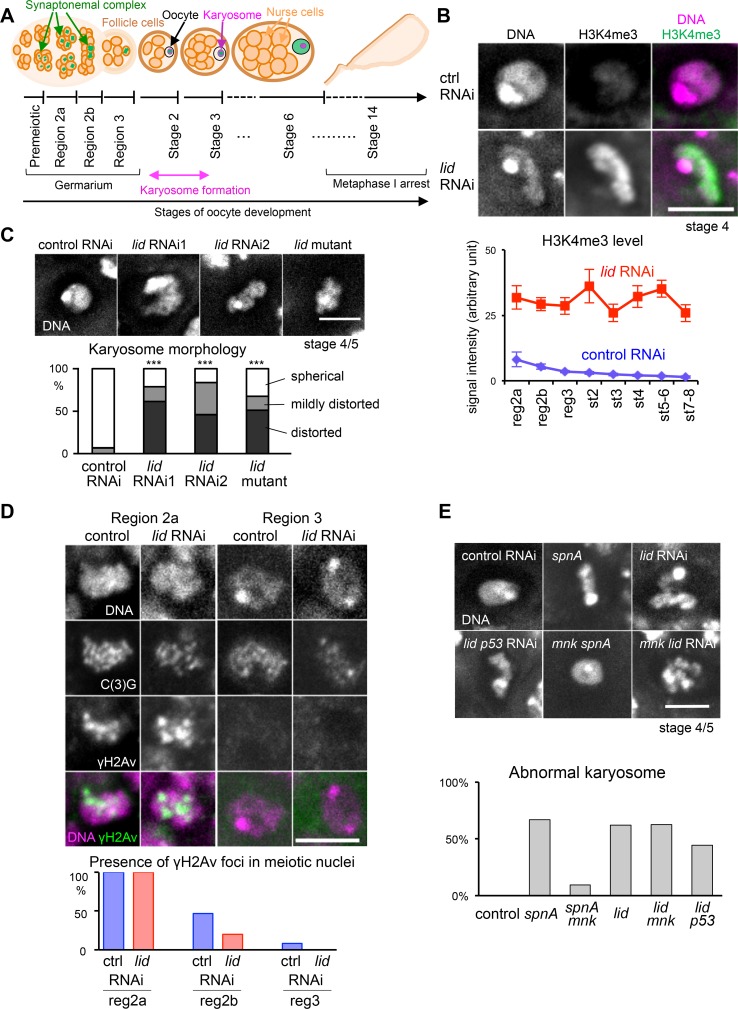
Loss of Kdm5/Lid results in high H3K4me3 and abnormal karyosomes independently from the meiotic recombination checkpoint.(A) Schematic representation of Drosophila oogenesis. A germline stem cell produces a cystoblast which undergoes four rounds of pre-meiotic mitosis to form a cyst consisting of 16 cells. In region 2a, up to four cells in a cyst initiate meiosis and form the SC. In region 2b, two cells (pro-oocytes) maintain the meiotic state. By region 3, one of these cells is finally selected as the oocyte, and all other cells have become nurse cells. Karyosome forms at stage 2–3 of oogenesis. At stage 3 and later, the SC gradually disassembles from chromosome arms, except in centromeric regions. At stage 14, the oocyte completes maturation and arrests in meiotic metaphase I. (B) The spatial distribution and quantified level of H3K4me3 in control and Kdm5/lid RNAi oocytes. The total H3K4me3 signal intensity was significantly higher in Kdm5/lid RNAi oocytes at all stages (p<0.001). n≥7. Error bars represent the standard errors of the mean. reg; region, st; stage. (C) Karyosome defects caused by two different shRNAs (lid RNA1 and lid RNAi2) and a Kdm5/lid mutant (lid10424/k06801). The karyosome morphologies at stages 3–9 were classified into three categories: "spherical" when the karyosome shows a spherical shape, "mildly distorted" when spherical shape was distorted but largely maintained, and "distorted" when spherical shape was largely disrupted. *** indicates a significant difference from the control (p<0.001). n≥18. (D) γH2Av foci which mark DSBs in meiotic nuclei in region 2a, 2b and region 3 of control and Kdm5/lid RNAi ovaries. DSBs are repaired by region 3 in both. Meiotic nuclei were identified by C(3)G staining. n≥12. (E) Karyosome morphology at stage 4/5 in control RNAi, Rad51/spnA, Kdm5/lid RNAi, Chk2/mnkp6/+
spnA double mutant, Chk2/mnkp6/+ mutant with Kdm5/lid RNAi, and Kdm5/lid p53 double RNAi. The frequency of abnormal karyosomes at stage 3–9 was quantified for each genotype. n≥16. Suppression of meiotic checkpoint does not rescue the karyosome defect of Kdm5/lid RNAi (p = 1.00). Scale bars = 5 μm.